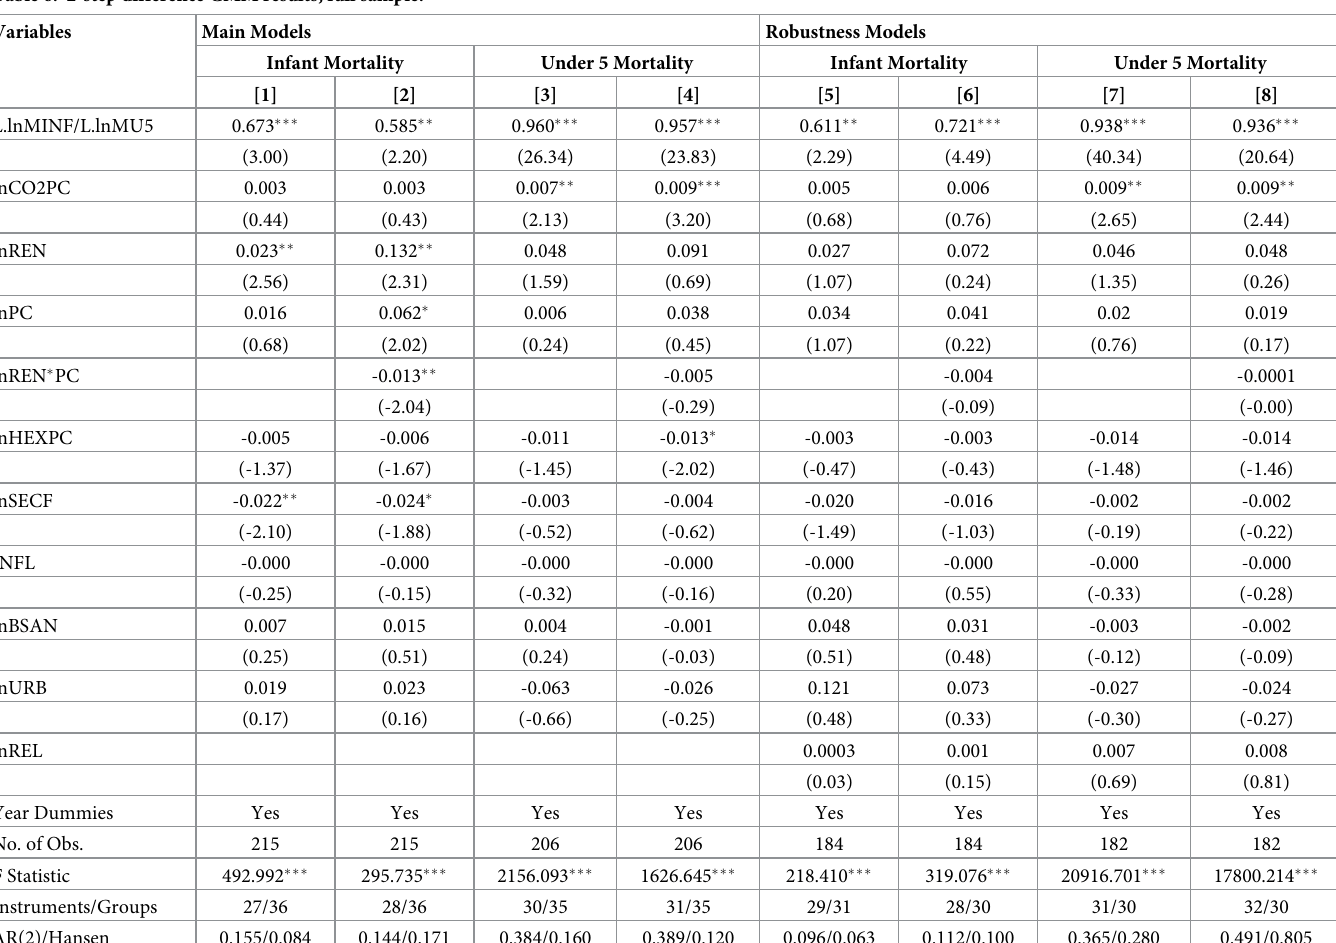
Table 6. 2-step difference GMM results, full